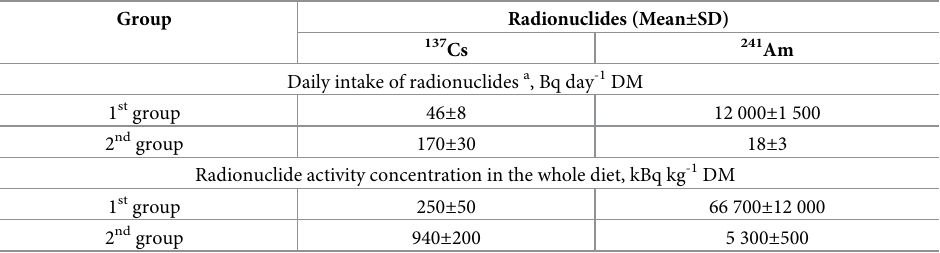
radionuclides ( 137 Cs and 241 Am) in the all-in-one feed was below the minimum detectable activity. Intakes of radionuclides by the study broilers, taking into account the mass of refused feed (not more than 5% of each source), are summarized in Table 3.